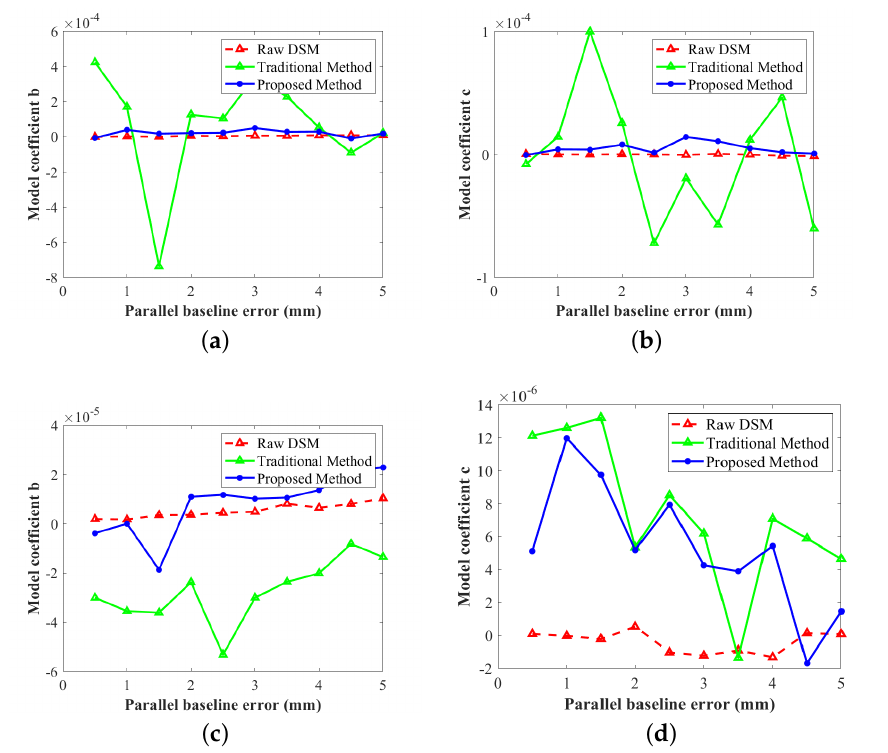
Figure 9. The coefficients of adjustment model: ( a , b ) are the range and azimuth tilts of the track containing the seventh to ninth images, respectively, while ( c , d ) are the coefficients of the track containing the first to third images.